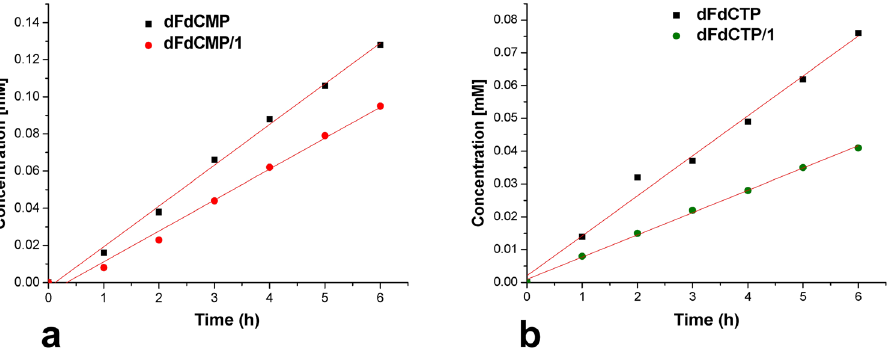
Figure 4. Diffusion experiments. Concentration vs time, determined at 37 °C, PBS, pH 7.4 of ( a ) dFdCMP alone (1 mM, black circles, R 2 = 0.9958) and in the presence of 1 (1:1 molar ratio, red circles, R 2 = 0.9898) and ( b ) dFdCTP alone (1 mM, black circles, R 2 = 0.9878) and in the presence of 1 (1:2.5 molar ratio, green circles, R 2 =